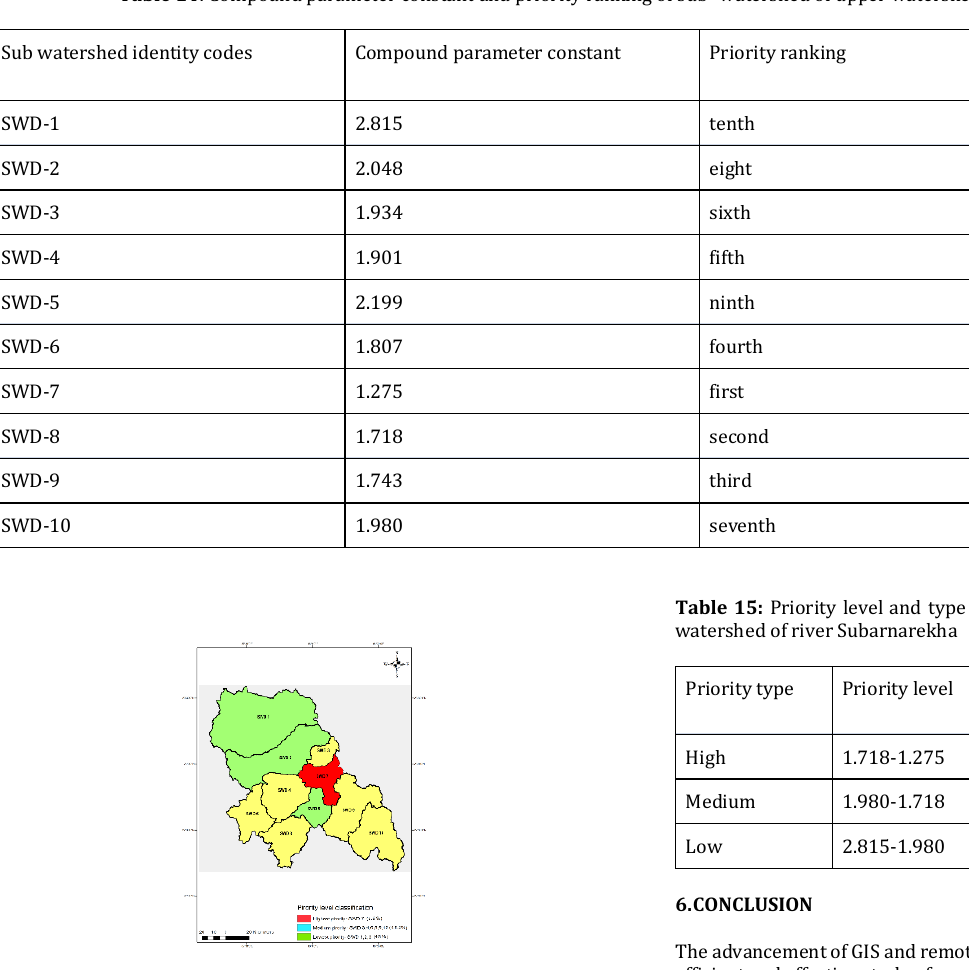
Table 14 : Compound parameter constant and priority ranking of sub- watershed of upper watershed of river Subarnarekha